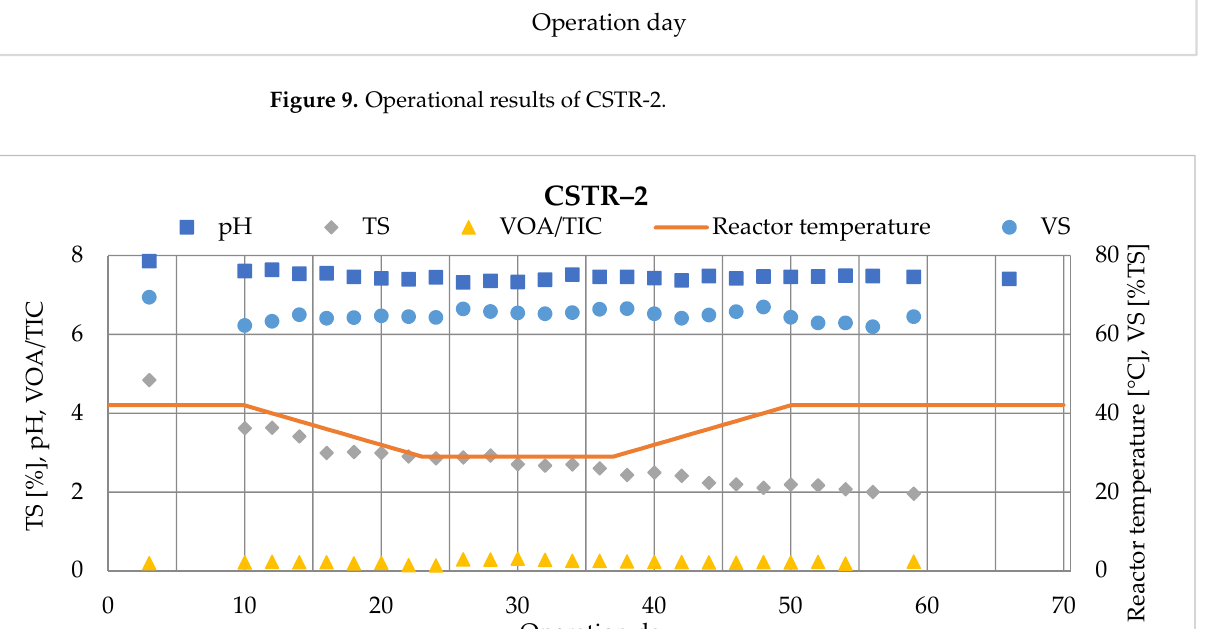
Figure 9. Operational results of CSTR-2.